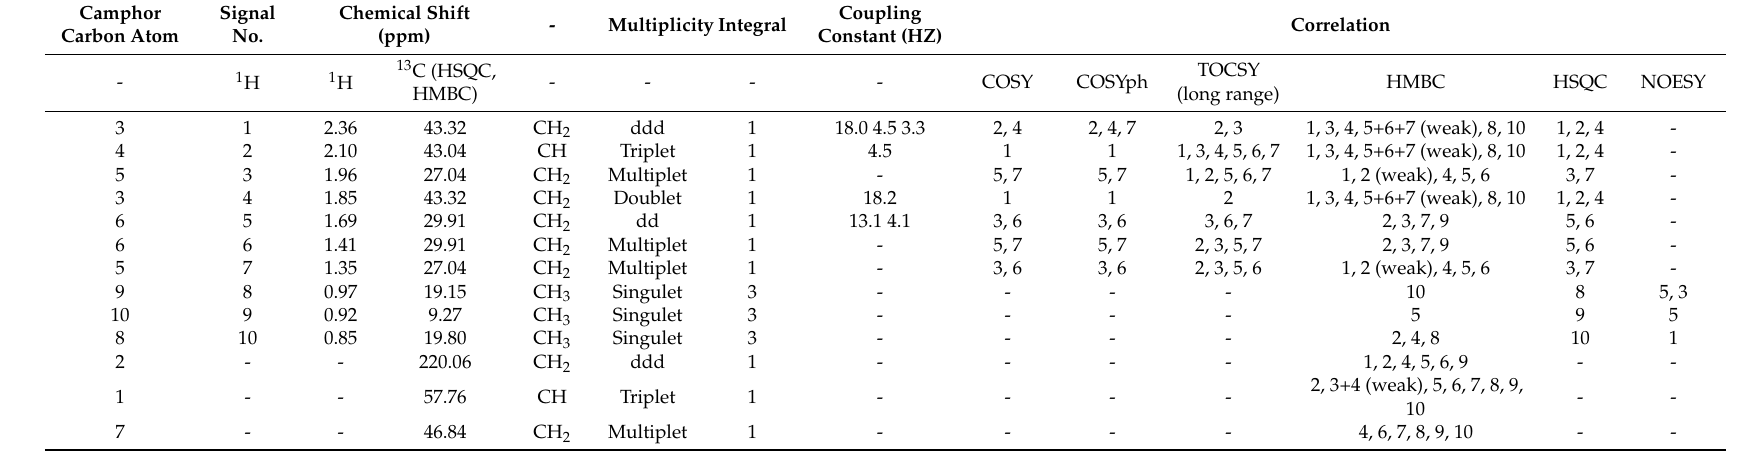
Table 3. NMR Signal assignment for